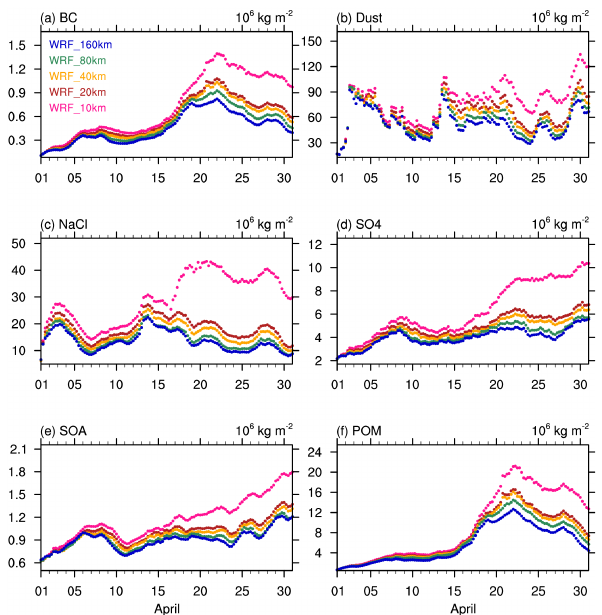
Fig. 9. Time series of total column burden of (a) black carbon, (b) mineral dust, (c) sea salt, (d) sulfate, (e) secondary organic aerosol, and (f) primary organic matter (10 6 kgm − 2 ) in the Arctic (north of 66.5 ◦ N).